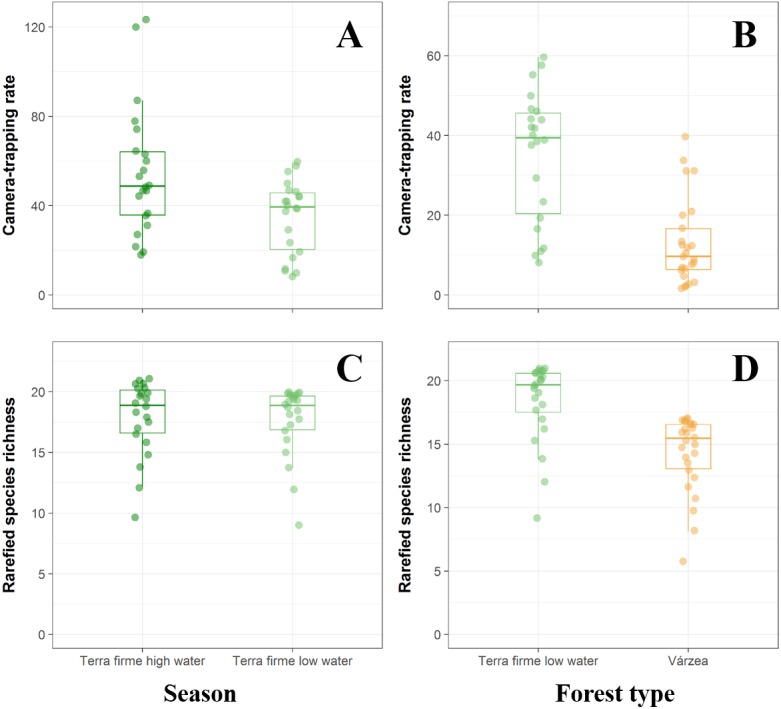
Comparison between terra fime and várzea forests during both the high- and low-water phases of the flood pulse considering both the total abundance and species richness of terrestrial forest vertebrates.Boxplots comparing abundance and rarefied species richness between terra firme forests during both high- (dark green) and low-water (light green) phases of the flood pulse (A and C) and between várzea (orange) and terra firme forests (light green) during the low-water phase (B and D).